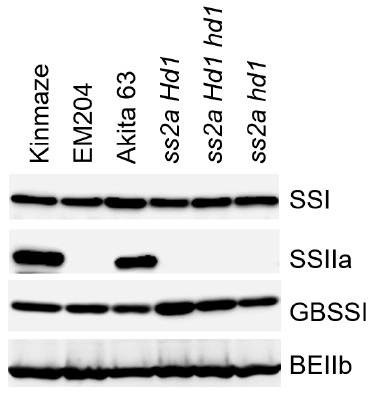
Figure 4. Western blotting analysis of total protein extract prepared from the mature seeds of different rice accessions. Starch biosynthetic enzymes were detected using the corresponding antibodies.